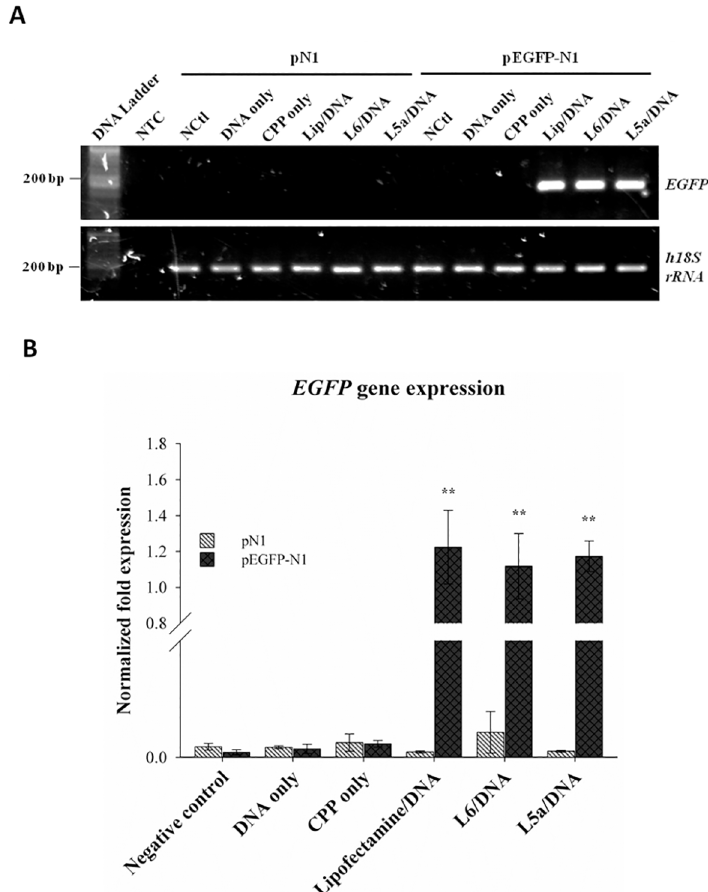
Fig 4. Real-time PCR analysis of cellular delivery of reporter gene plasmid mediated by L6 and L5a. (A) Final RT-PCR products of EGFP and 18S rRNA genes from the cells after uptake of the peptide/DNA complexes. Cells were not treated (negative control, NCtl) or were treated with DNA alone, CPP alone, Lipofectamine 2000/DNA (Lip/DNA) or CPP/DNA complexes for 24 h. Real-time PCR for the detection of EGFP gene expression was conducted using a Bio-Rad iQ5 Real-Time PCR Detection System. Human 18S rRNA gene expression was analyzed as an internal control. Negative control (NTC) represents real-time PCR signal in the absence of a DNA template. (B) Real-time PCR analysis of EGFP gene expression. EGFP gene expression recorded in panel A was normalized to 18S rRNA expression. Statistical comparisons were performed by ANOVA. Data are presented as mean ± SD from three independent experiments in each treatment group. Significant differences from cells without any treatments (negative control) at P < 0.01 ( ** ) are